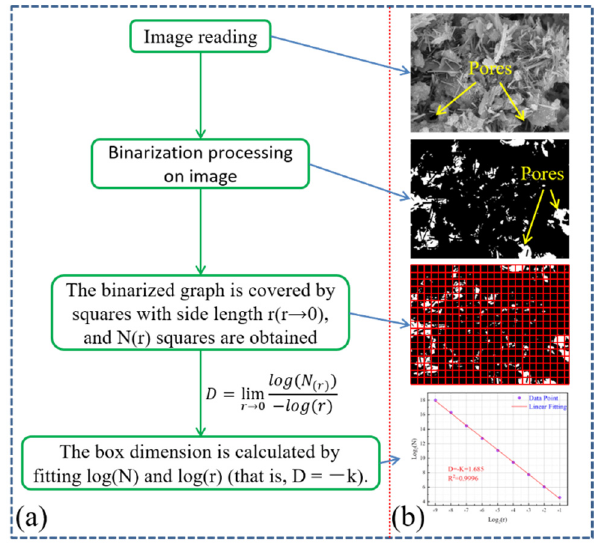
Figure 10. The treatment process of SEM image by box dimension. ( a ): the flow chart ( b ): the treatment process diagram